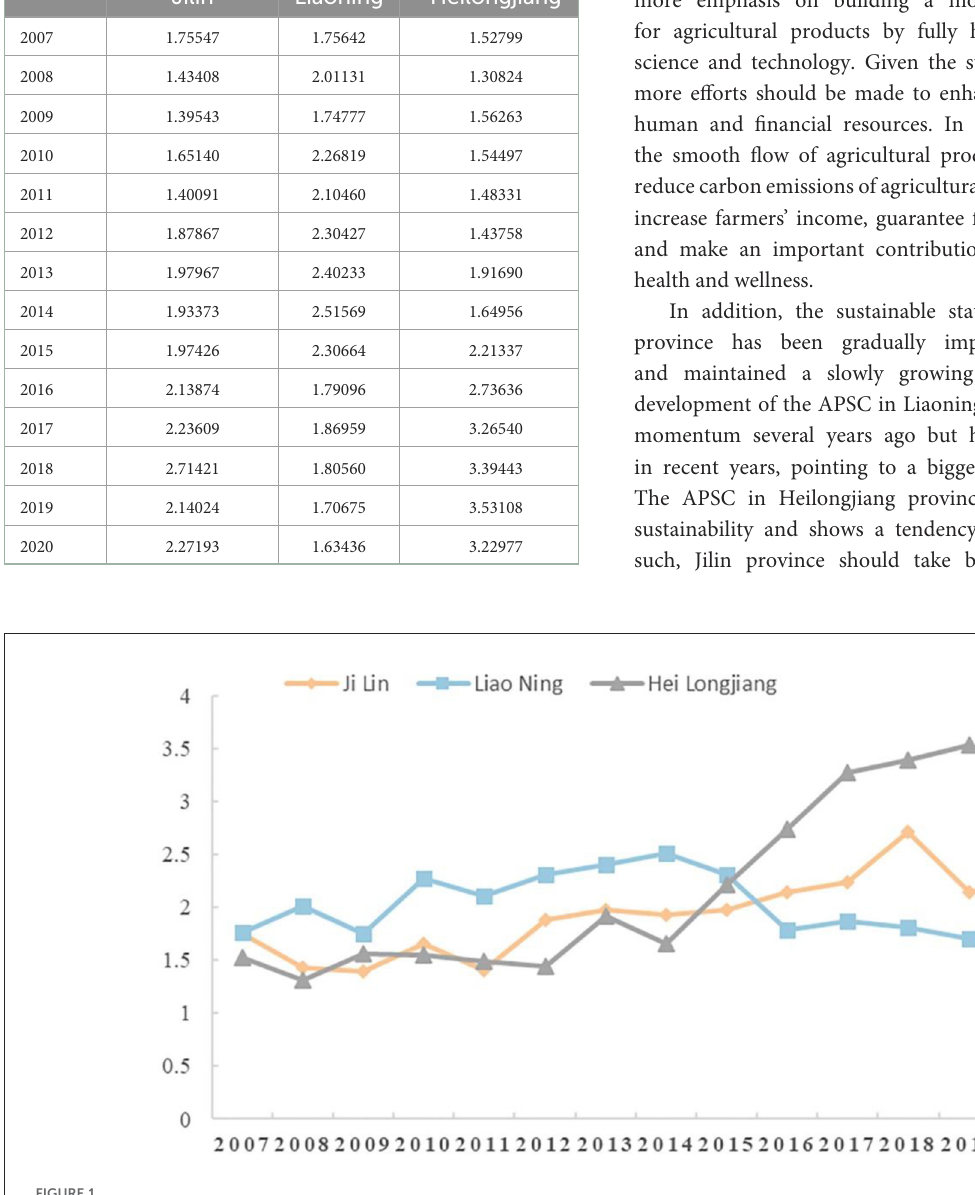
FIGURE1 Line chart of evaluation grade changes of the sustainable development of APSC in the three provinces in Northeast